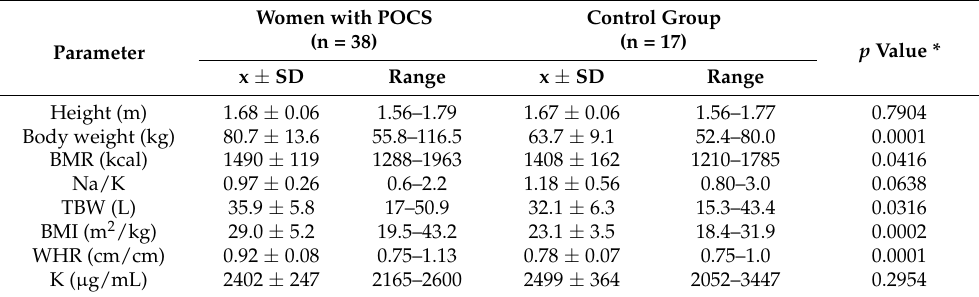
Control Group (n = 17)